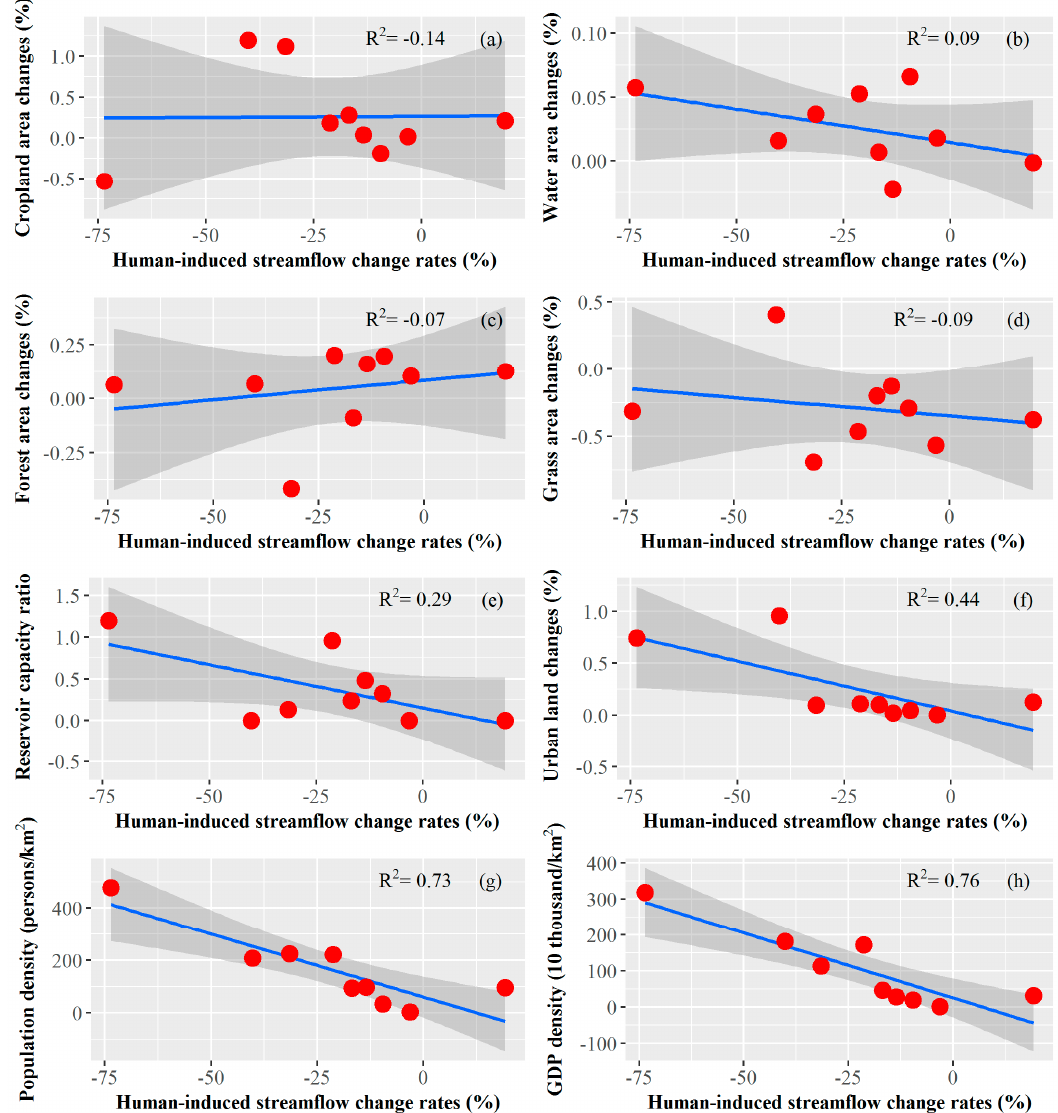
Figure 7. Relationships between human-induced streamflow changes and underlying parameter ( n ), population density, and GDP. Percentage of land use/cover changes denotes the ratio between land use types to the entire drainage area.